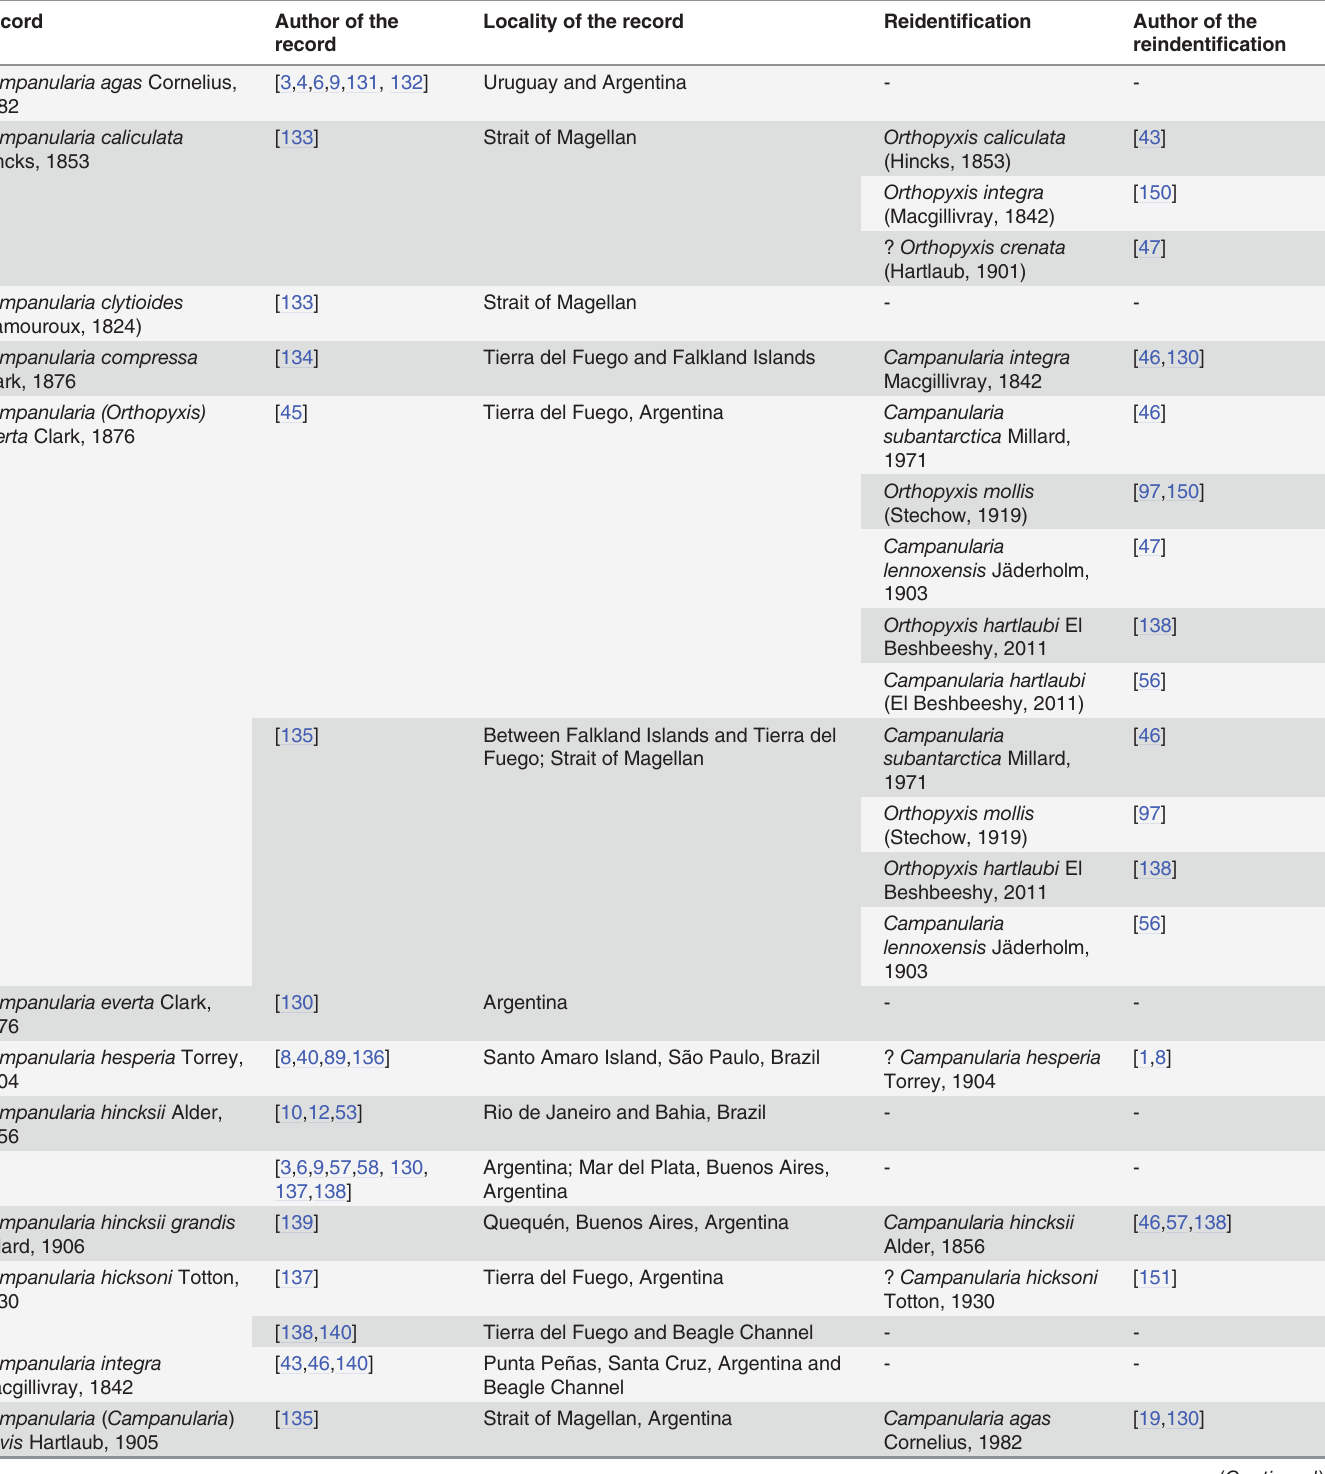
Table 1. Records of species of Orthopyxis and Campanularia from the southwestern Atlantic, including their reidenti fi cations, according to the